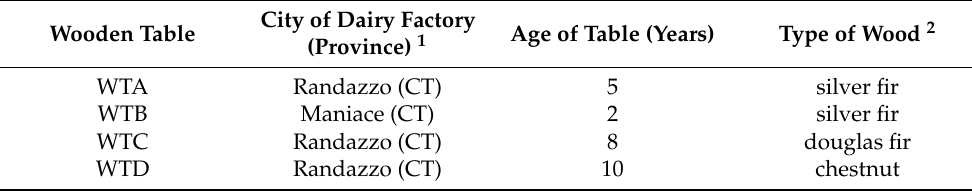
Table 1. Characteristics of the wooden tables used for curd acidification of PDO Provola dei Nebrodi cheese production. City of Dairy Wooden Table